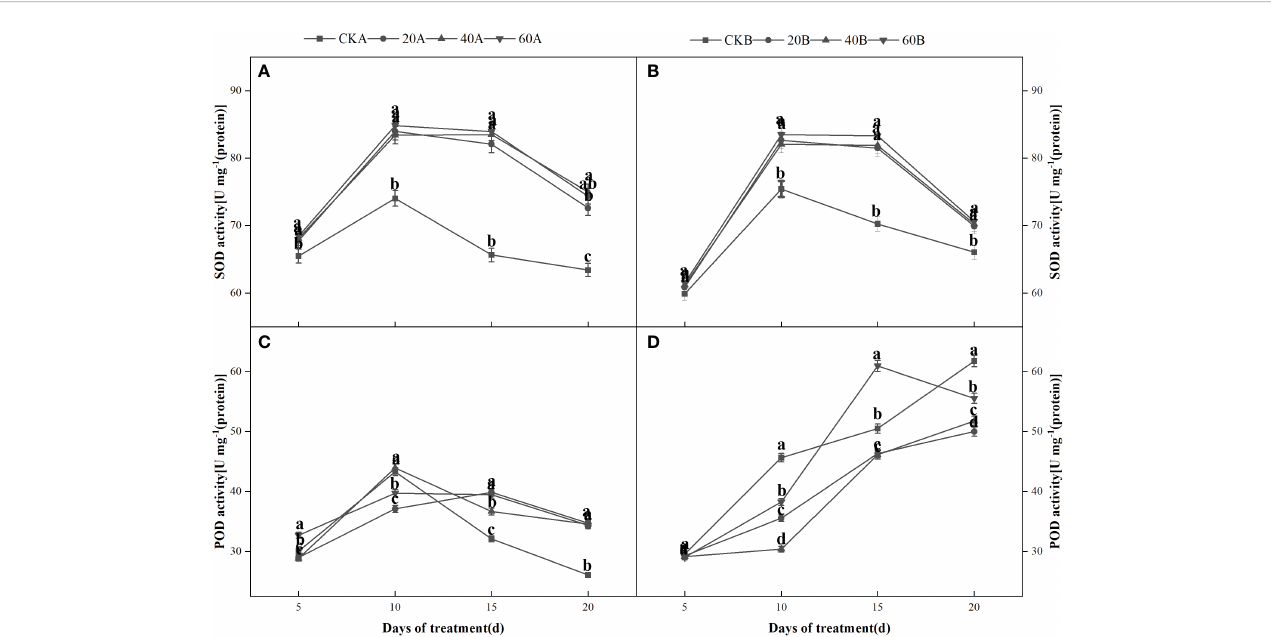
FIGURE 7 Effects of GA 3 on antioxidant enzymes contents in different light-sensitive inbred maize lines after different periods under low light stress. In the fi gure panels, 20A, 40A, and 60A denote SN98A sprayed with 20 mg L – 1 , 40 mg L – 1 , and 60 mg L – 1 GA 3 , respectively, and 20B, 40B, and 60B denote SN98B sprayed with 20 mg L – 1 , 40 mg L – 1 , and 60 mg L – 1 GA 3 . CKA denotes the SN98A control group sprayed with water and CKB denotes the SN98B control group sprayed with water. In the fi gure, (A, C) represent the changes of H 2 O 2 and O – 2 after SN98A is treated with GA 3 . (B, D) are the changes of H 2 O 2 and O – 2 after SN98B is treated with GA 3 . Values are expressed as mean ± SD of three replicates. Lower-case letters indicate the mean difference of different treatments in the same period, which is statistically signi fi cant (P<0.05).